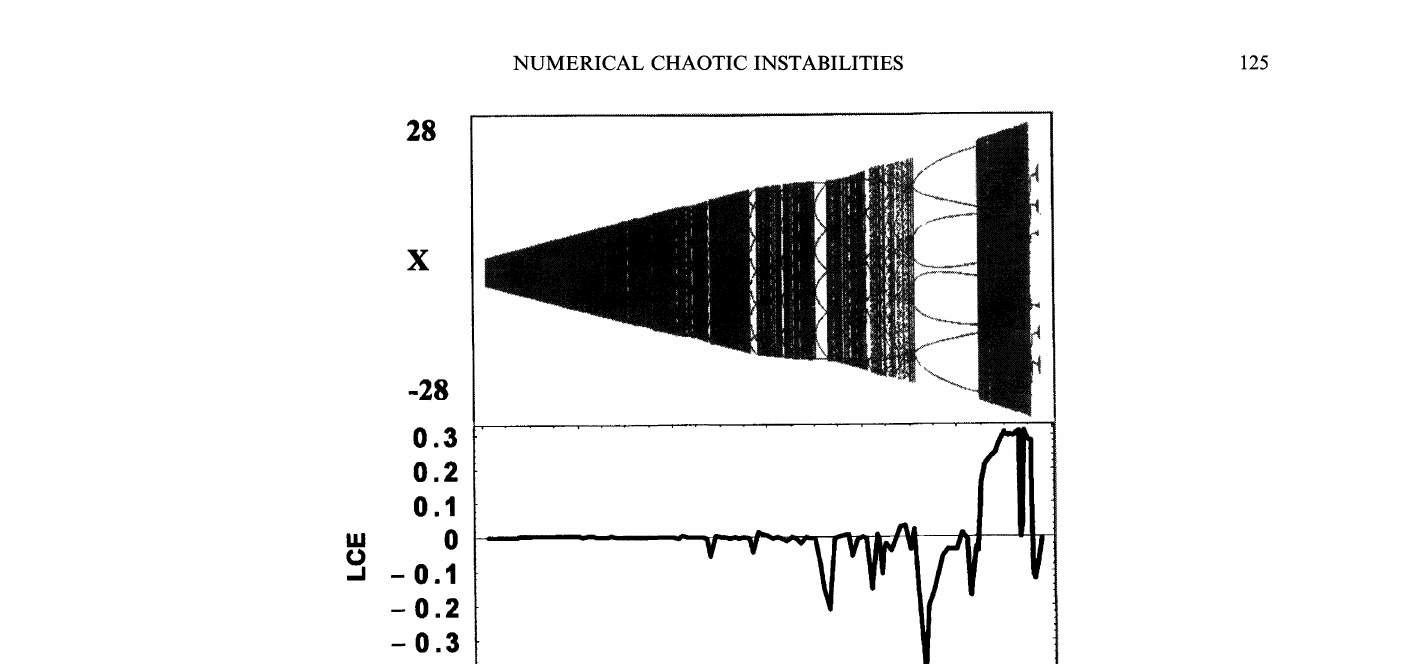
FIGURE Largest Lyapunov characteristic exponent and bifurcation plots as a function of the step size of the standard forward Euler scheme used to integrate the Lewis oscillator (1) for e --0.1. The onset of numerical instabilities is marked distinctively about h* 0.45.